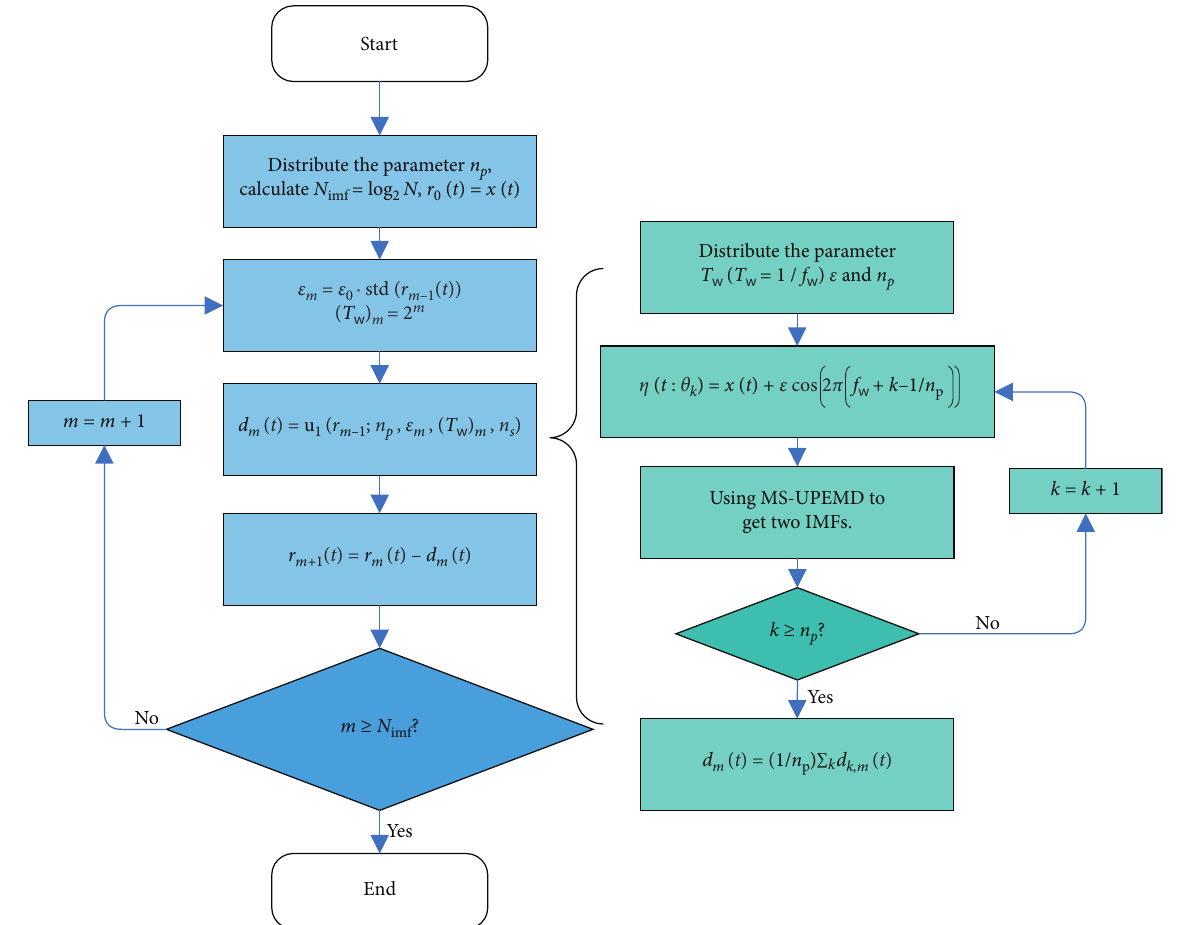
Figure 1: The flowchart of the Multi-level UPEMD method used in this